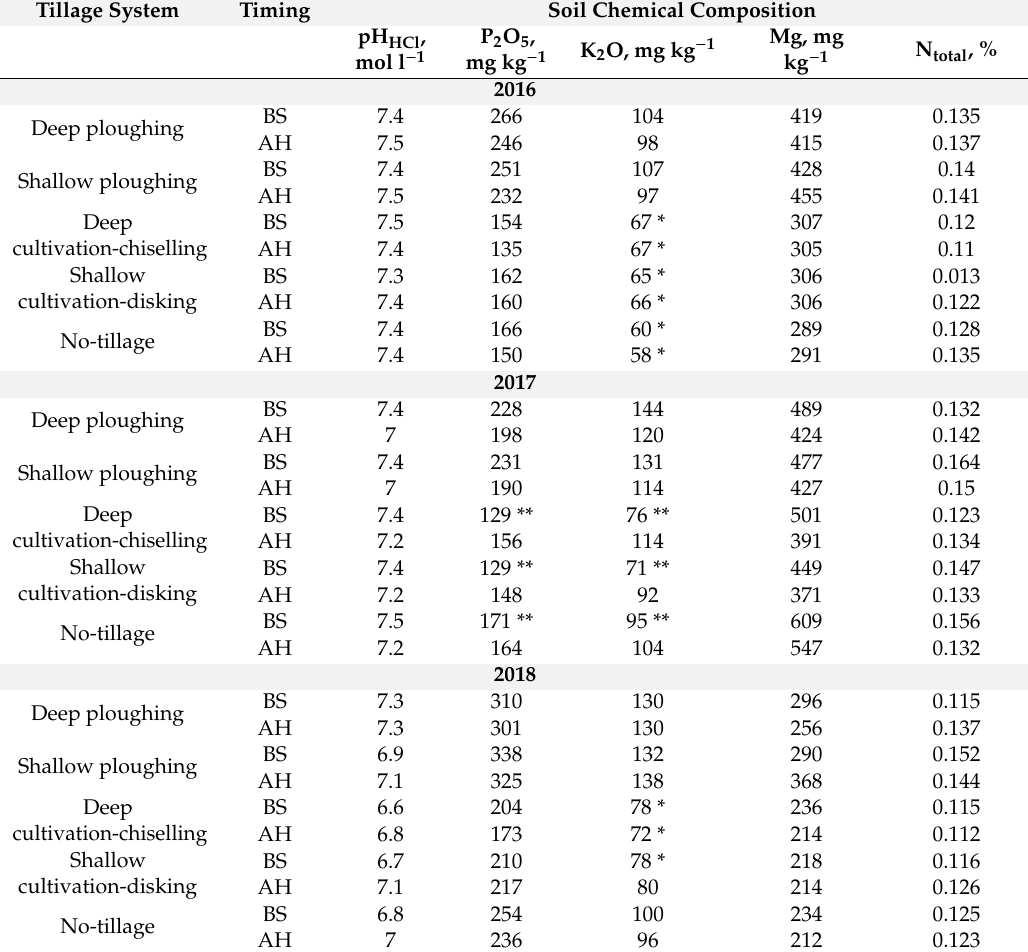
Table 4. The e ff ect of the tillage systems on the soil chemical composition (15–25 cm soil layer). Tillage